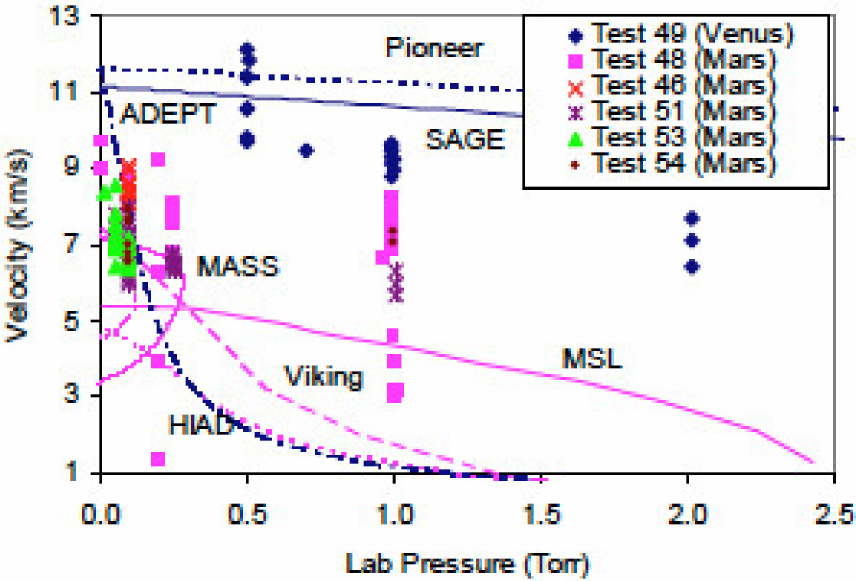
Figure 7. Summary of tests carried out in EAST for Mars ad Venus entries from 2008 to 2012 [17].